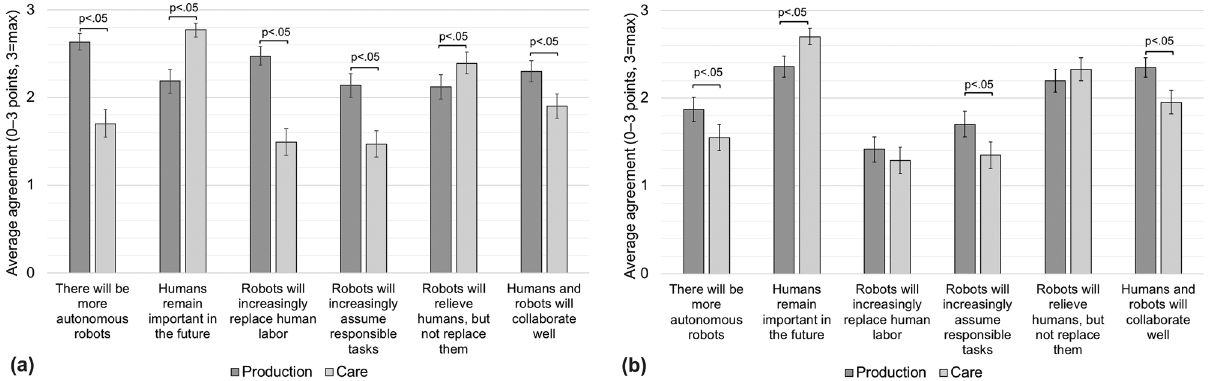
Figure 4: E ff ect of usage context on expectations ( left ) and evaluations ( right ) of future HRC. ( a ) Expectations about future HRC in both contexts ( “ Do you believe that [ … ] ? ” ) ( mean values with 95% con fi dence interval ) . ( b ) Evaluations of future HRC in both contexts ( “ Do you appreciate that … ? ” ) ( mean values with 95% con fi dence interval ) .